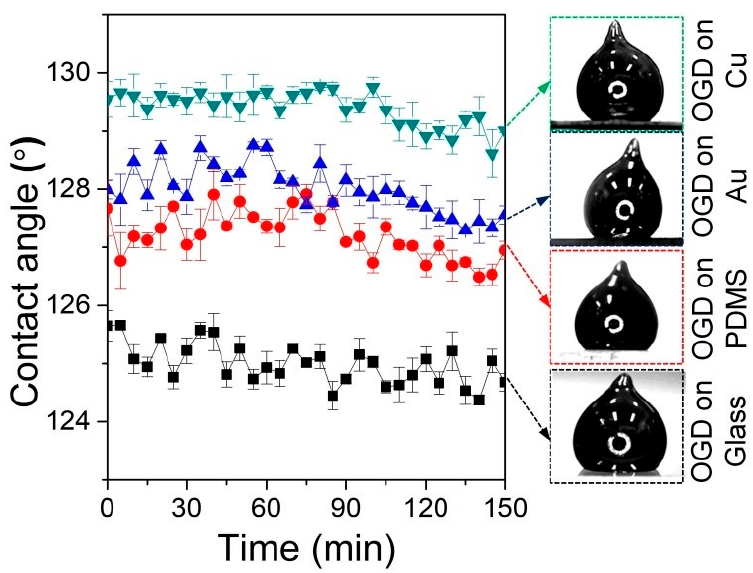
Figure 1. The static contact angles of the OGD on various substrates (Glass, PDMS, Au and Cu) as a function of time.